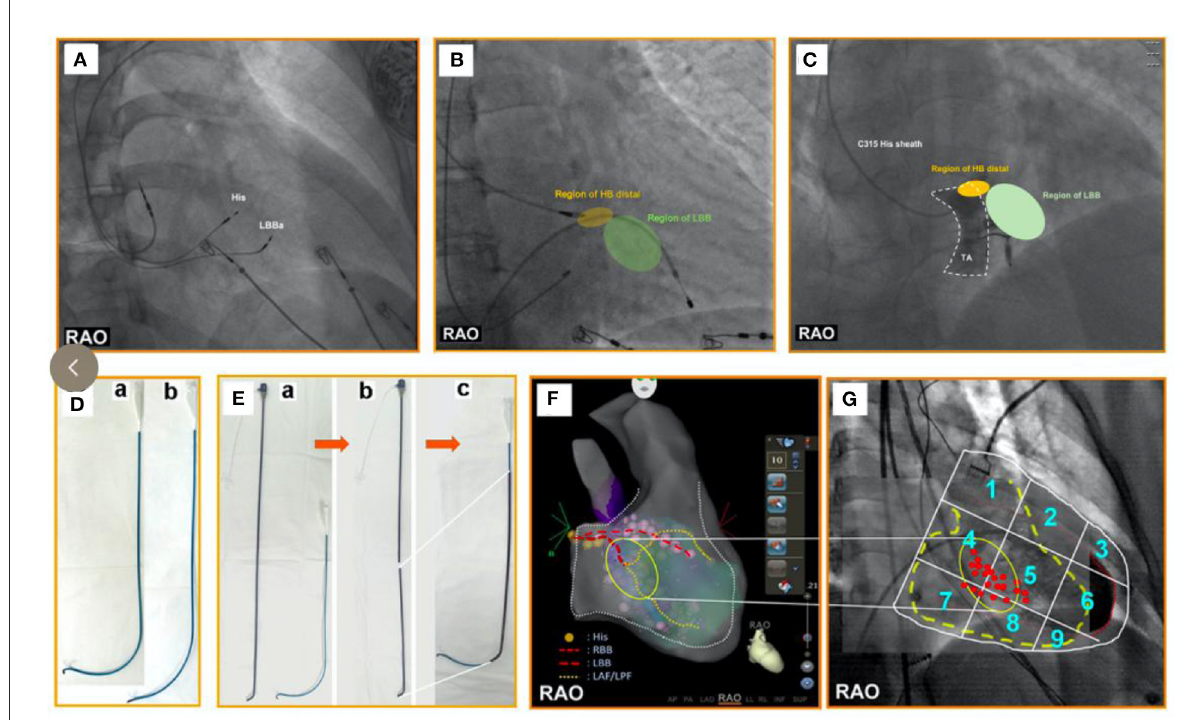
FIGURE2 (A) One pacing lead is placed in the His-bundle region—an anatomical landmark. Another pacing lead is screwed into the LBBa. The position of the LBBaP is about 1–1.5cm distal to the HBP lead position (i.e., the site of the first pacing lead) in the interventricular septum along the line connecting the HBP position and right ventricular apex from the RAO view. (B) The yellow area represents the HB distal region. The green area represents the LBB region that is regarded as an initial implant site of LBBaP. The region of LBB is ∼ 1–1.5cm distal to the region of HB in the interventricular septum along the line between the region of HB and the right ventricular apex in the right anterior oblique view. (C) The area surrounded by the white dotted lines represents TA. The yellow area represents the HB distal region that is close to the TA summit. The green area represents the LBB region that is regarded as an initial implant site of LBBaP. From the RAO view, the region of LBB is ∼ 1–1.5cm distal to the region of HB in the interventricular septum along the line between the region of HB and the right ventricular apex. (D) a. The C315HIS delivery sheath with regular curvature; b. The C315HIS delivery sheath with increased curvature. (E) a. Atrial septal puncture sheath (8.5F, T1, 62cm) and C315HIS delivery sheath; b. Severed atrial septal puncture sheath (8.5F, T1, 62cm); c. C315HIS delivery sheath coated part of atrial septal puncture sheath. (F) His bundle and LBB are tagged under three-dimensional mapping, followed by pacing lead positioning into the LBBa. (G) We numbered the 3 × 3 partitions from 1 to 9 in the RAO fluoroscopic image of the ventricle. Most successful initial implant sites were found at the junction of the partition zones “4/5/7/8” with more points located in zones “4 and 5”. RAO, right anterior oblique; LBBa, left bundle branch area; HB, His bundle; LBB, left bundle branch; TA, tricuspid annulus; HBP, His bundle